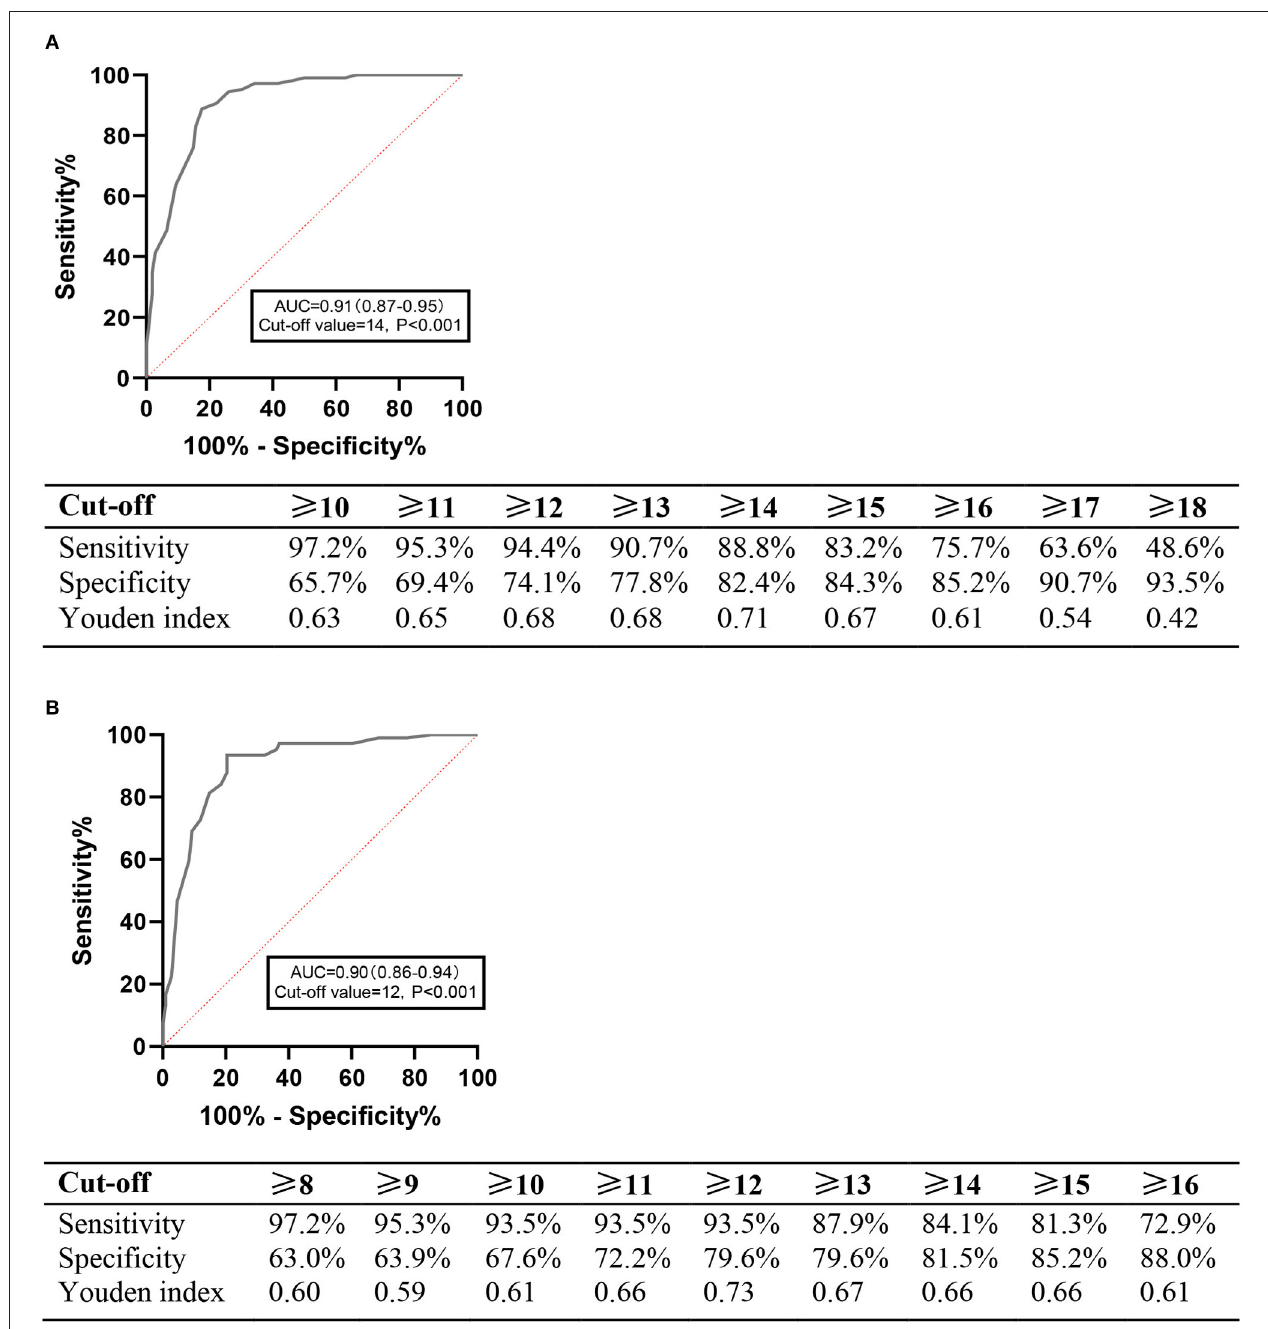
FIGURE 2 | ROC analyses. (A) ROC curve for the HCL-33. (B) ROC curves for the HCL-33-EA.